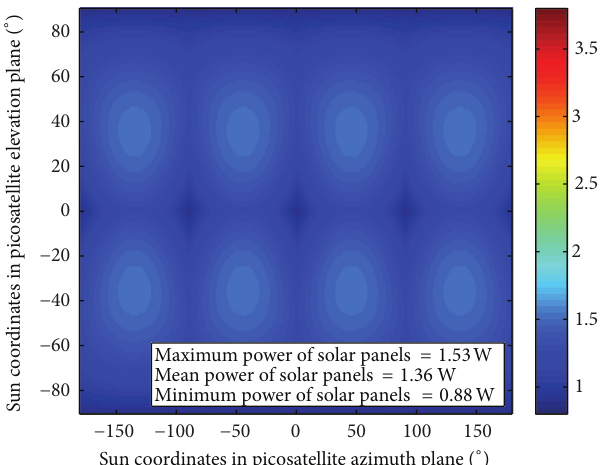
Figure 4: Power generation of gallium arsenide based solar panels placed on CubeSat walls—solar cell temperature 60 ∘ C; angle effi- ciency dependence is not covered in